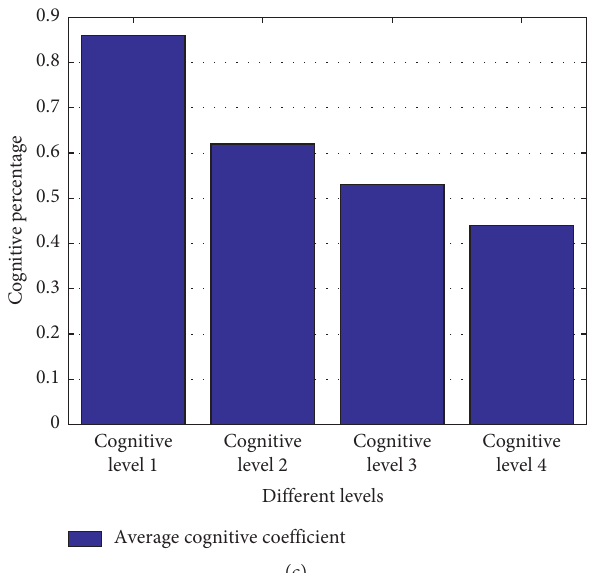
Figure 8: Reports of different roles of the massive education examination big data cloud platform. (a) Statistic results of grades. (b) Each class knowledge point average score rate. (c) Cognitive level score